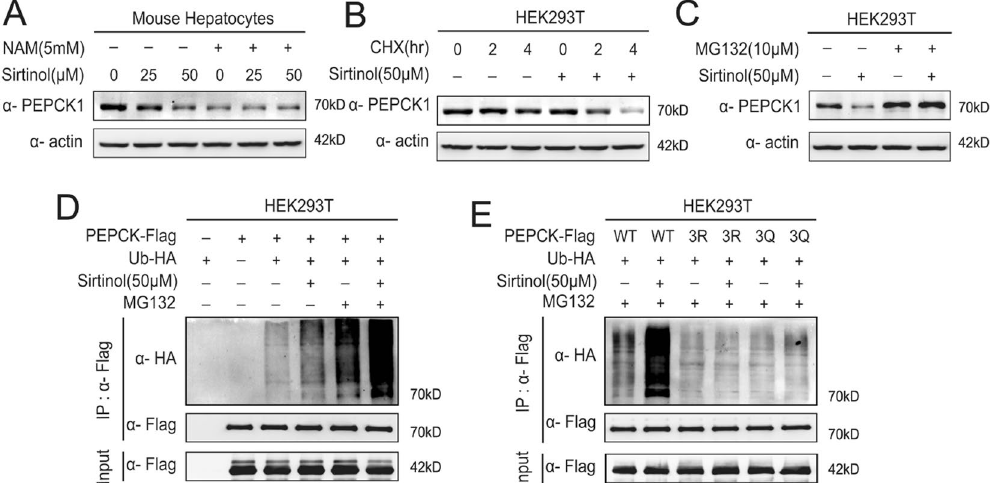
Figure 4. Sirtinol-induced acetylation promotes PEPCK1 degradation via ubiquitin-proteasome pathway. ( A ) Primary mice hepatocytes were treated with indicated sirtinol for 4 hours with or without 5 mM NAM for 6 hours. Cells were harvested and lysated, then visualized by Western blotting. ( B ) 293T cells treated with indicated CHX, with or without sirtinol 50 μ M for 4 hours. Cells were harvested and lysated, and endogenous PEPCK1 was visualized by Western blotting. ( C ) 293T cells treated with indicated MG132 with or without sirtinol 50 μ M for 4 hours. Cells were harvested and lysated, and endogenous PEPCK1 was visualized by Western blotting. ( D ) Flag-tagged PEPCK1 and HA-tagged ubiquitin were coexpressed in HEK293T cells, then treated with indicated sirtinol for 4 hours with or without 10 μ M MG132 for 4 hours. Ubiquitination levels of affinity purified Flag-PEPCK1 proteins were detected and visualized by Western blotting. ( E ) Different phenotypic Flag-tagged PEPCK1 and HA-tagged ubiquitin were coexpressed in HEK293T cells, then treated with indicated sirtinol for 4 hours with or without 10 μ M MG132 for 4 hours. Ubiquitination levels of affinity purified Flag-PEPCK1 proteins were detected and visualized by Western